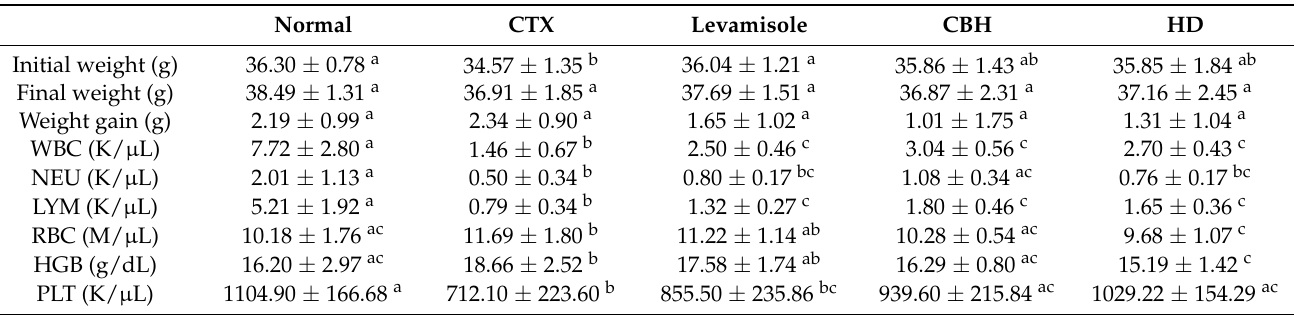
Table 1. The effect of CHB and HD on the body weight and hematological parameters of CTX- treated